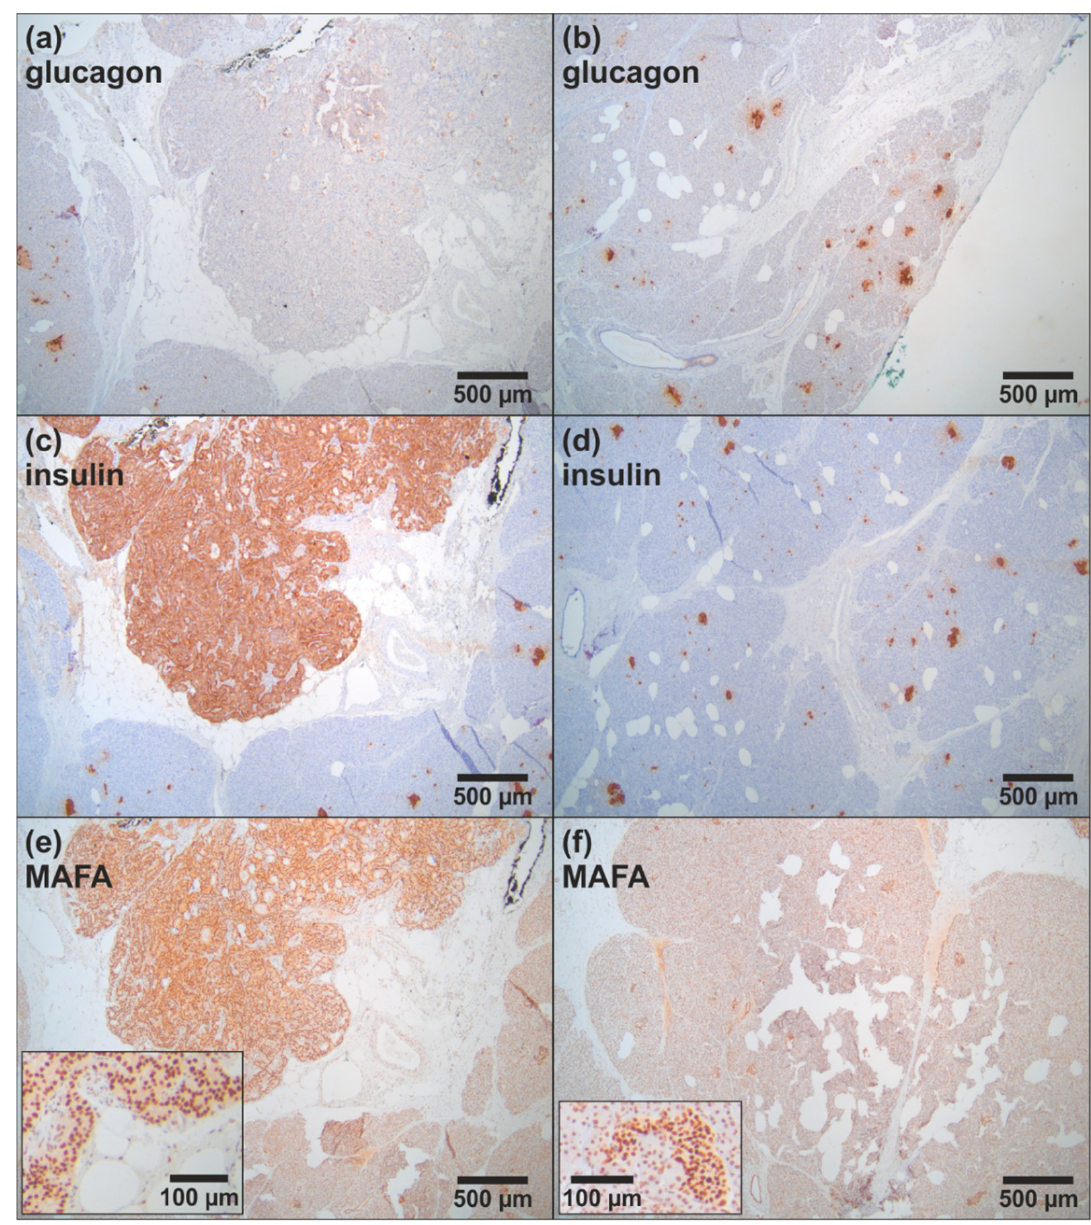
Figure 3. Glucagon, insulin and MAFA immunohistochemistry of case 1 (IV4). Immunohistochemical staining of serial sections of the resected pancreatic specimen of case 1 showing a solitary insulinoma (left panels ( a , c , e )) and normal pancreatic tissue with multiple pancreatic islets (right panels ( b , d , f )).